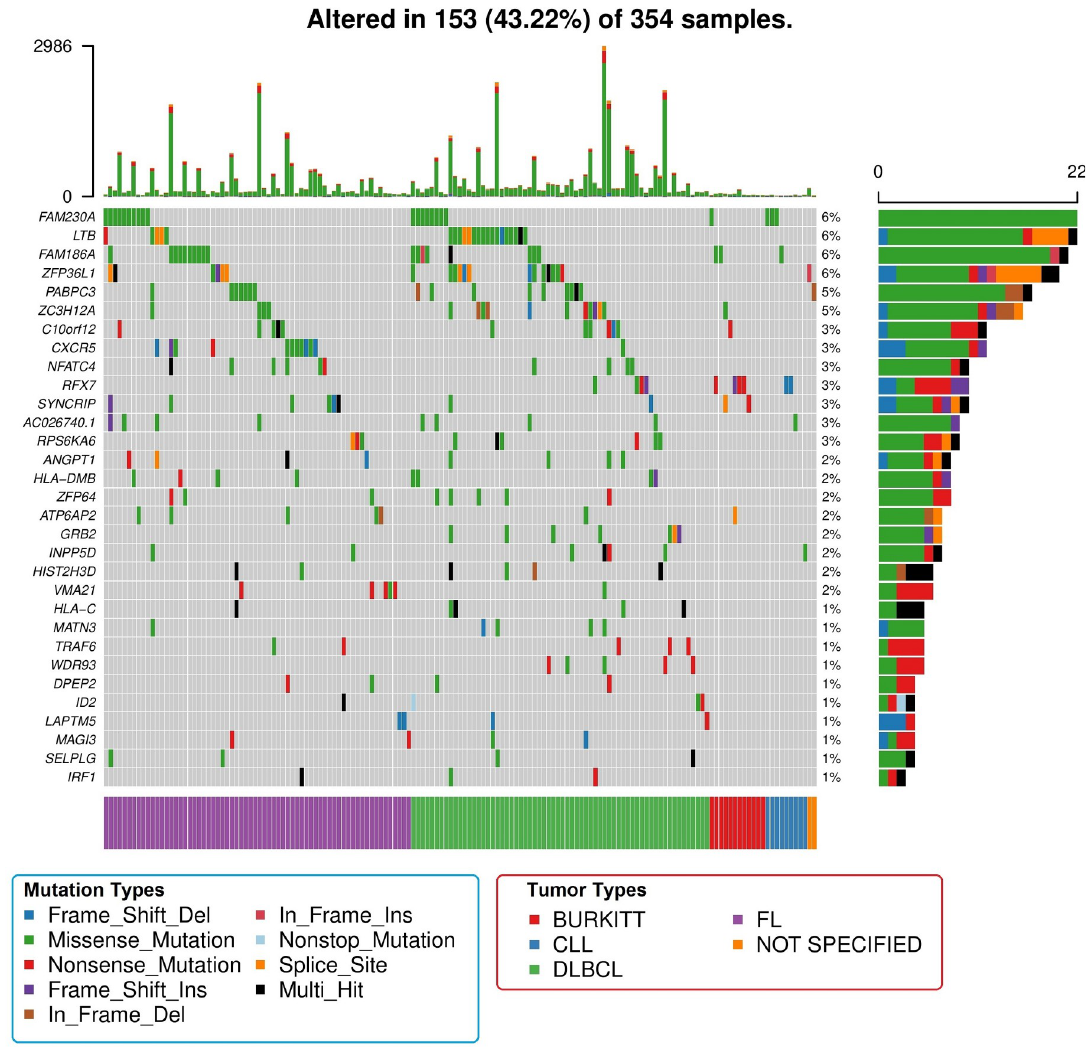
Fig 2. Representation of the new drivers discovered in this analysis. Image details are identical to those of the previous image. Table ). 122 of these regions overlapped genes targeted by aSHM in lymphomas, and signature analysis indicated that another 4 regions were also likely targets of aSHM. On the contrary, 54 regions affecting 25 different genes were not affected by aSHM by signature analysis. Pathway analysis revealed significant overlaps between these genes and the following pathways: “Tran- scriptional misregulation in cancer” (q-value 8.55 x 10 − 3 ), “Pathways in cancer” (q-value 8.55 x